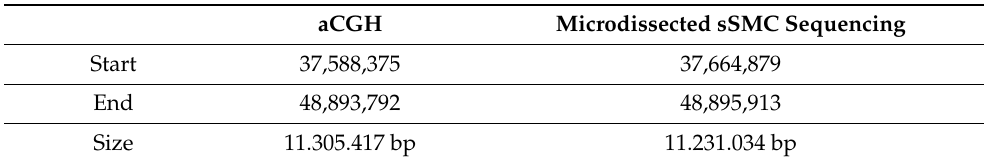
Table 1. Break-point coordinates in the sSMC(10) detected by aCGH and single-copy chromo- some sequencing.